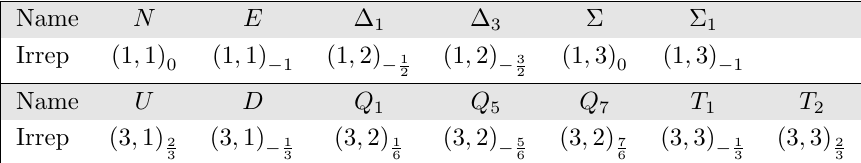
Table 2 . New vector-like fermions contributing to the dimension-six SMEFT at tree